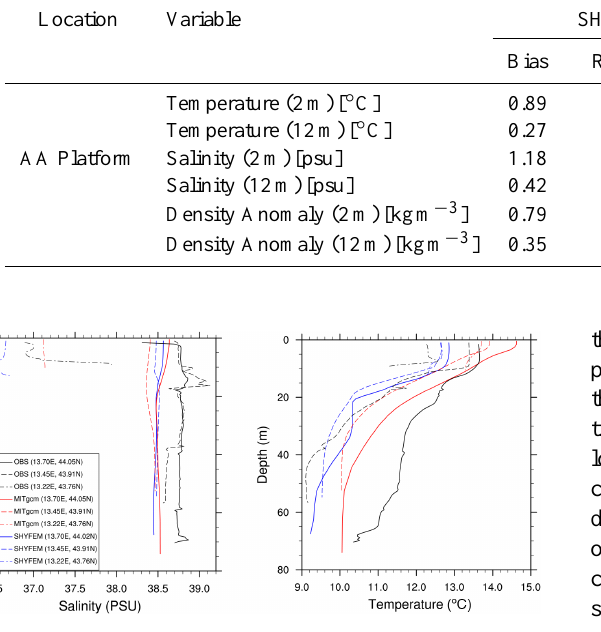
Figure 5. Senigallia transect: profiles of salinity (left) and temper- ature (right) for three CTD profiles along the transect for the 27 March 2012 (big red dots shown in Fig. 2). The inset shows com- parison between observations (black), SHYFEM (blue) and MIT- gcm (red) for the innermost, shallower profile (dash-dot), one in the center of the transect (dashed), and the outermost, deeper pro- file